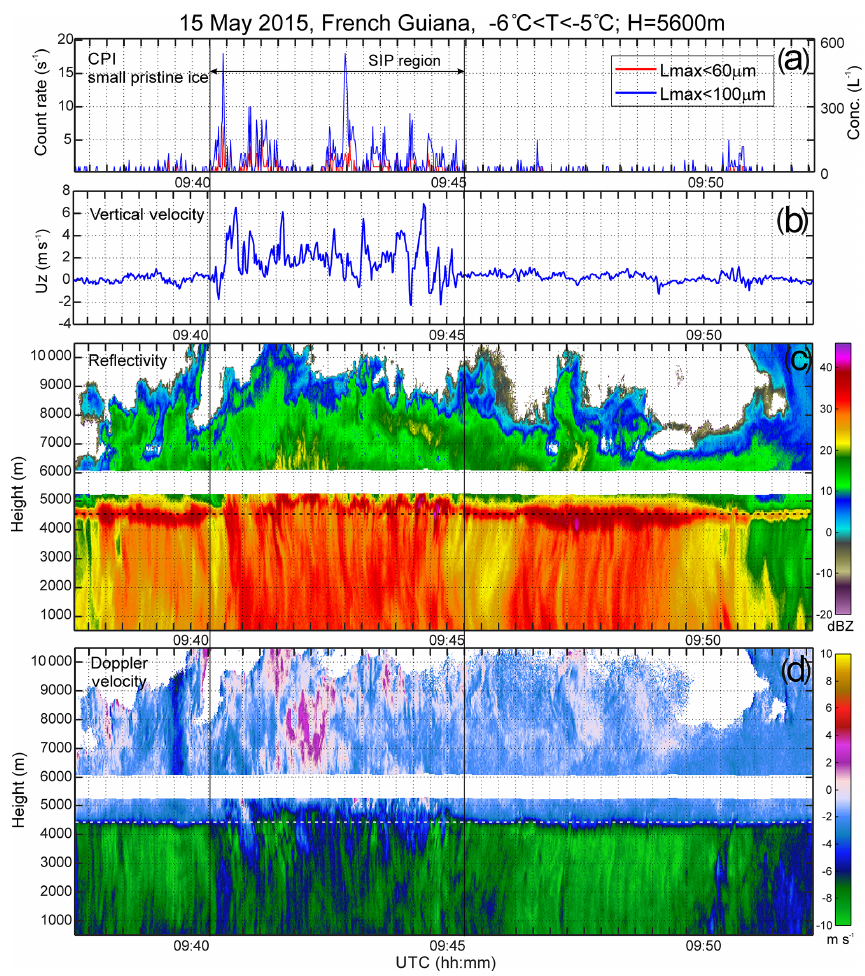
Figure 23. Zoomed time segments of the time series in Fig. 5 with the counting rate of small pristine ice particles (a) , vertical velocity (b) , X-band radar reflectivity (c) , and Doppler velocity (d) , measured during a traverse of the convective region inside a tropical MCS. Horizontal dashed lines in panels (c, d) show the level of the bright band undisturbed by convective updraft cloud regions. Two vertical solid lines indicate the SIP cloud region, which spatially coincides with the convective cell (b) and elevated bright band (c)